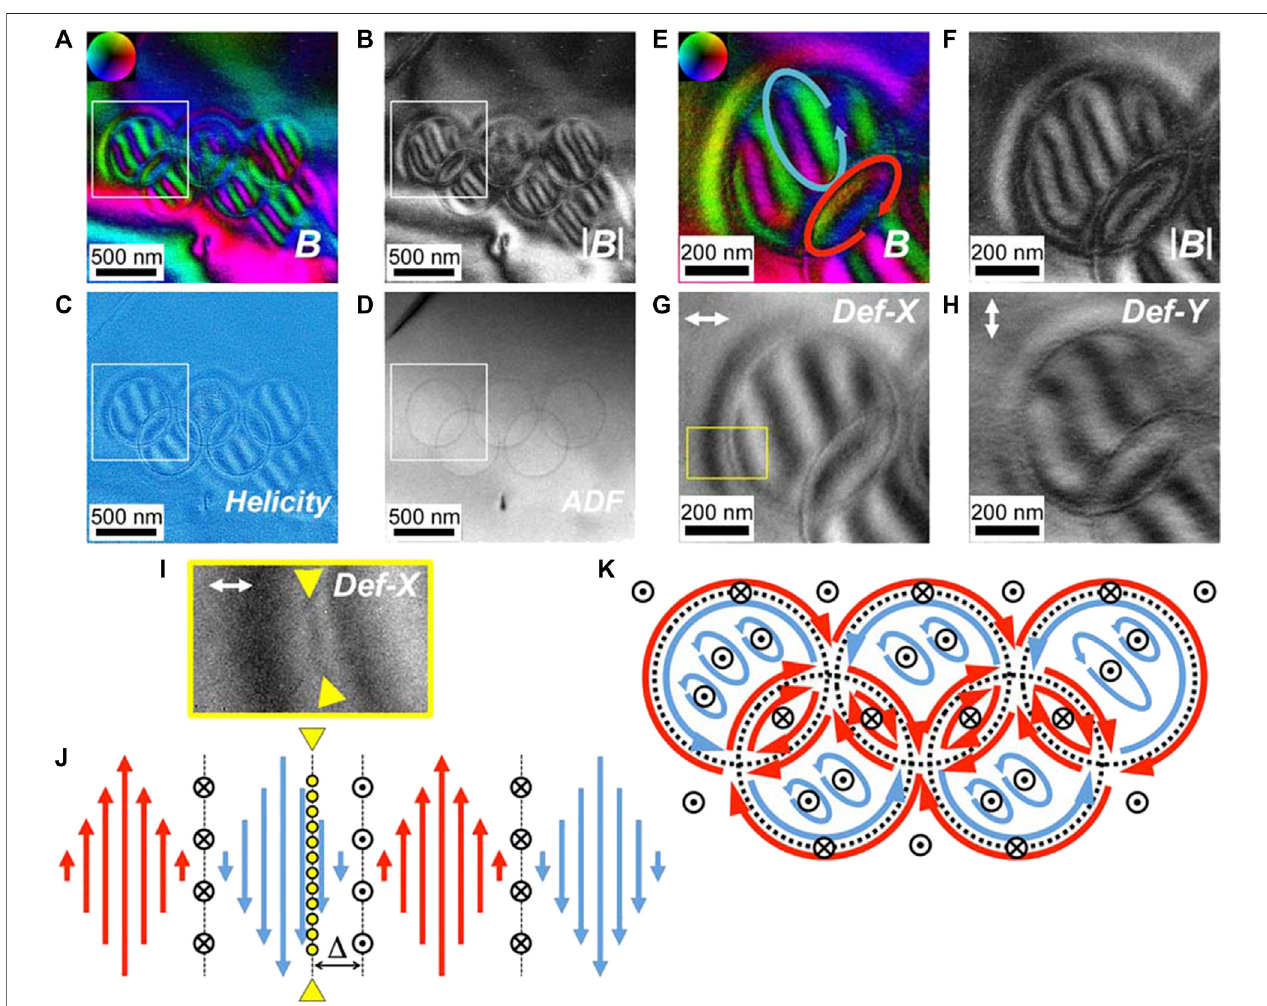
FIGURE6| Zero- fi eldskyrmionicspintexturecon fi nedtoasurface-pitcorralwithacomplexgeometry(Olympicsymbol). (A) In-planemagneticinductionasacolor map and (B) as intensity, (E) magnetic helicity image, and (F) annular dark- fi eld (ADF) image of the whole pattern. The boxed region in (A – D) is observed at a higher magni fi cation in (C,D,G,H) . Note that the horizontal and vertical de fl ection images are shown in (G) and (H) , respectively, instead of the magnetic helicity and ADF images. (I) Theboxed area indicatedby ayellowrectangle in (G) isenlarged. Thesurface-pitcorral isindicated byapairofyellow arrowheads. (J) Schematic ofthe left-handed helicalspin texture corresponding to (I) acrossthe surface-pit corral. The surface-pit corral isdisplayed asayellow dotted line,whichisindicated byapairof yellow arrowheads. (K) A simpli fi ed schematic of the plausible skyrmionic spin texture con fi ned in the Olympic symbol in zero- fi eld condition. The target mark symbols and crossed circle symbols indicate upward and downward directions,